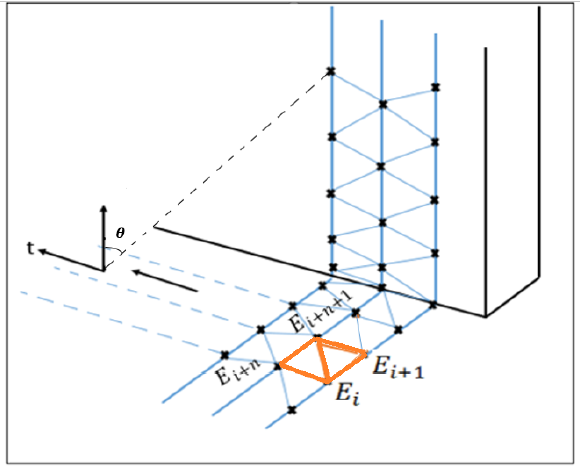
Figure 3. Triangulation based on the sensor space topology